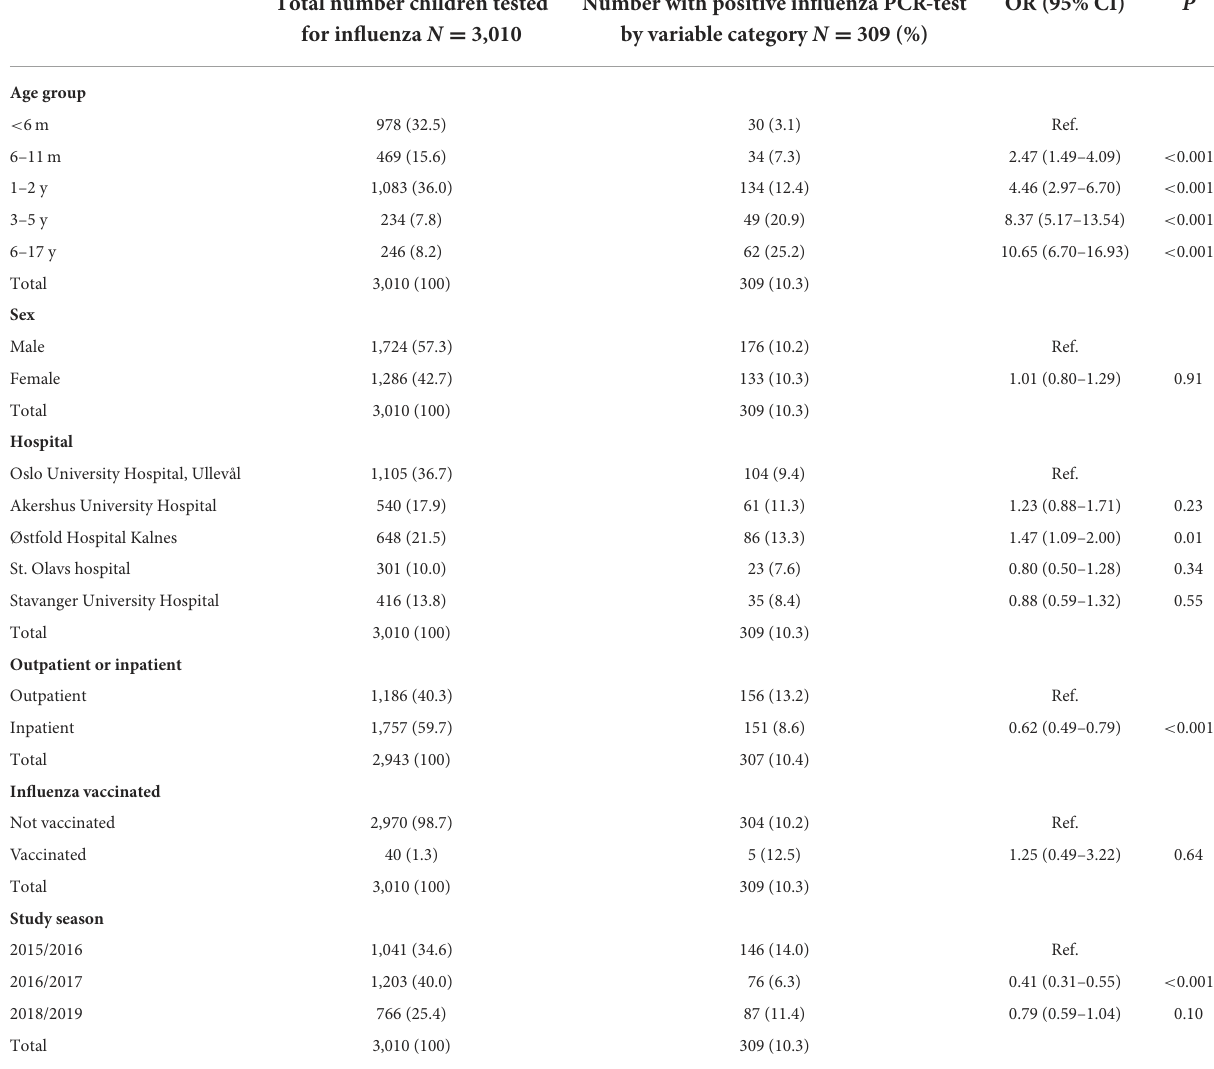
TABLE 1 Total number of enrolled children, with logistic regression comparing influenza positive and negative children within categories. Total number children tested Number with positive influenza